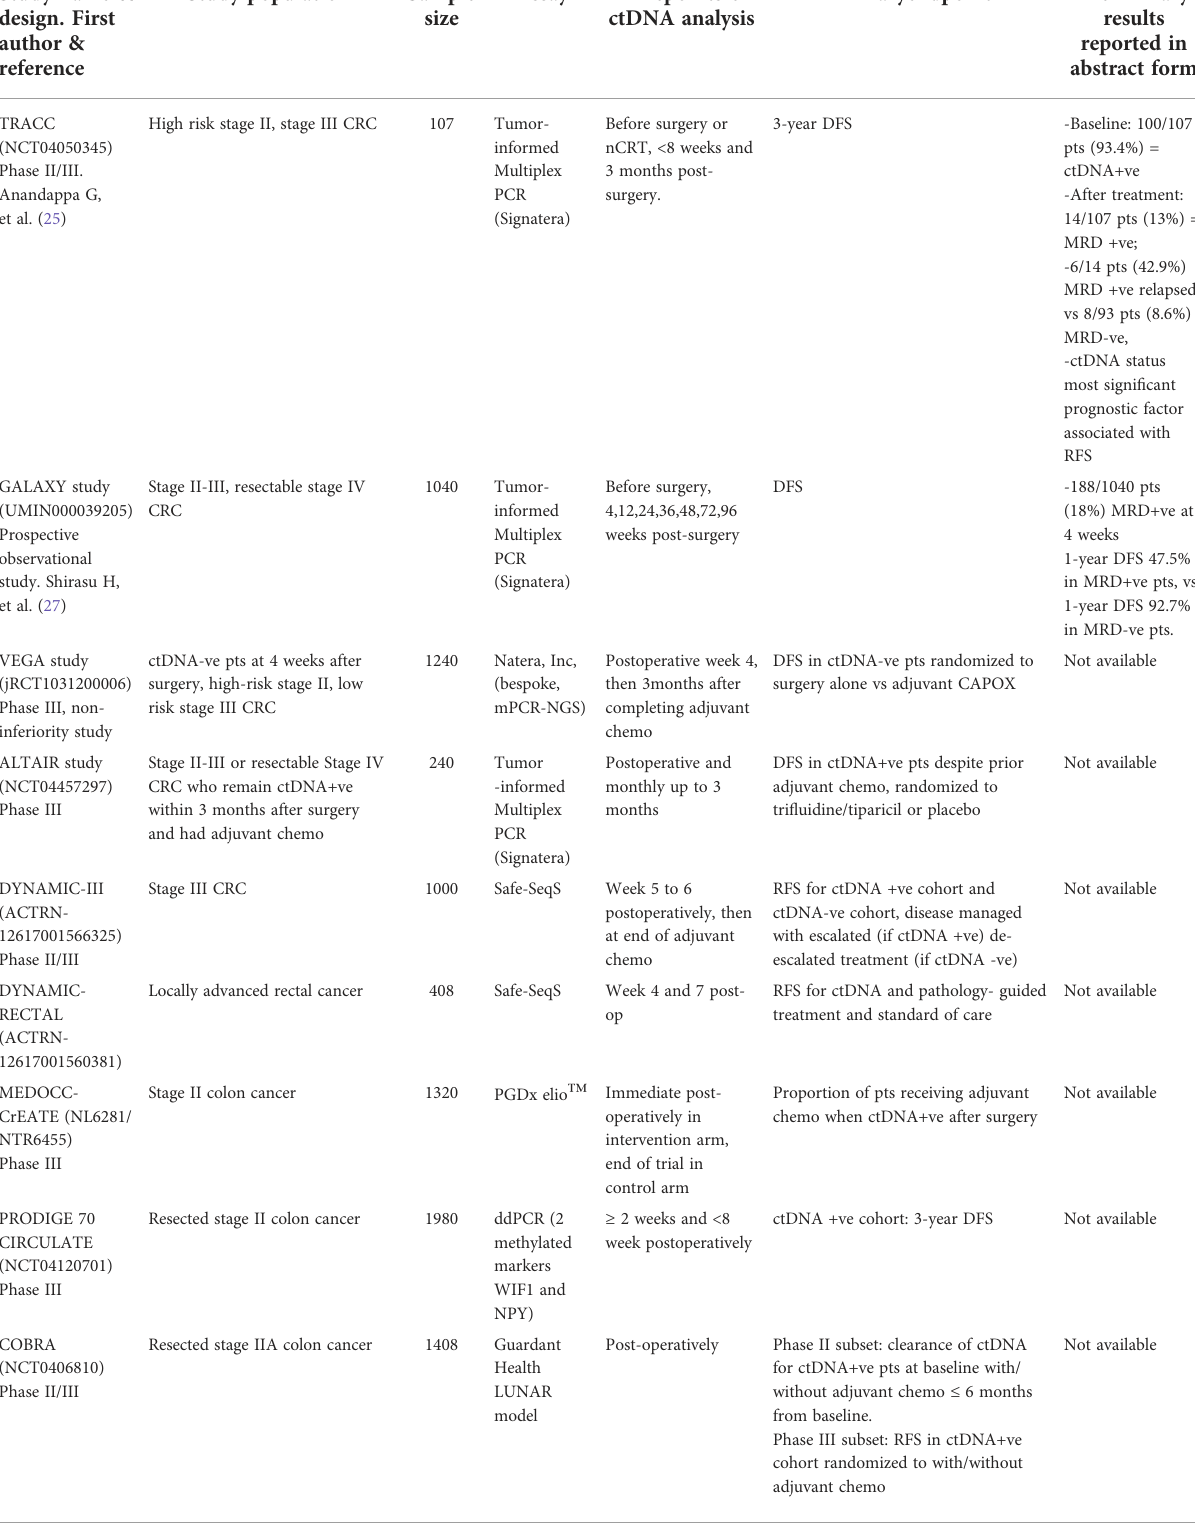
TABLE 1 Ongoing phase III or large observational studies or abstract-only reports on minimal residual